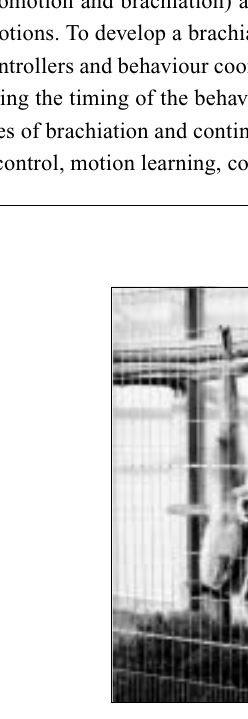
Figure 2 The white-handed gibbon ( Hylobates lar ).